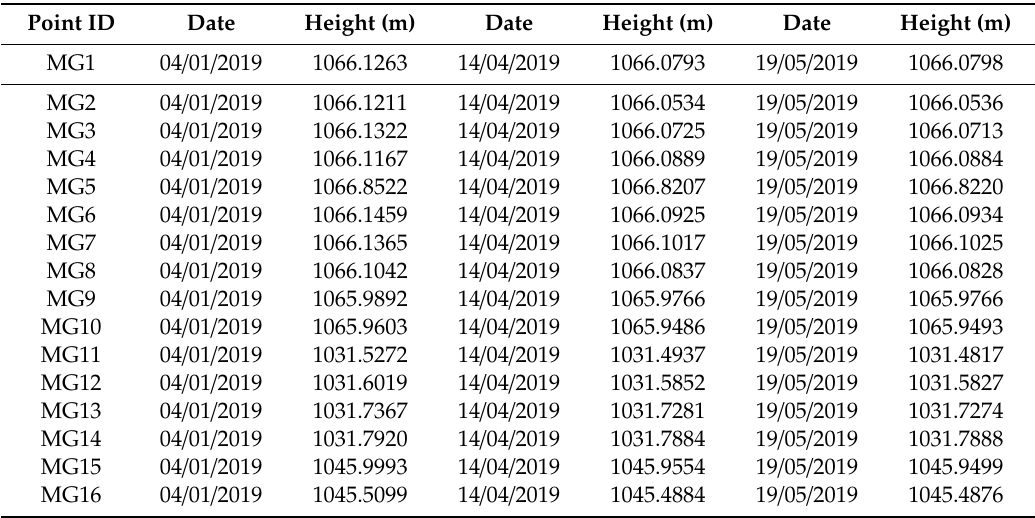
Figure 7. Settlement visualization of points MG11 to M16, from 04/01/2019 to 19/05/2019. Table 2. Height values of points MG1 to MG16, relating to the start and end time of second reservoir filing, and the time of the last